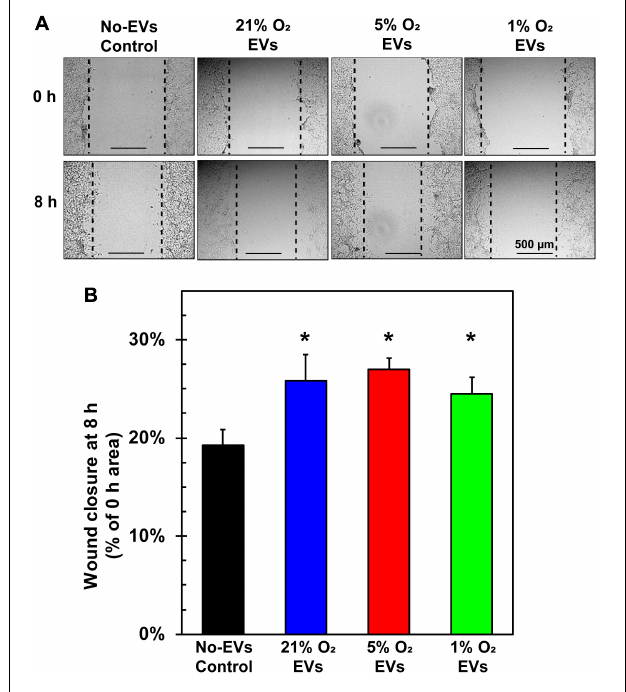
FIGURE 5 | Effect of hCPC-derived EVs on endothelial cell migration. BAECs were grown to confluence, wounded with a pipet tip, and treated with 100 µ g/ml of total EV protein from each condition. (A) Representative images from 0 and 8 h show the extent of cell migration, with dotted lines approximating the cell front. (B) Wound healing assay demonstrates that treating ECs with hCPC-derived EVs increased cell migration significantly when compared to No-EVs group. However, no significant differences were observed between 5 and 1% O 2 derived EVs. Data are shown as mean ± SD, n = 4, * p < 0.05 vs. No-EVs